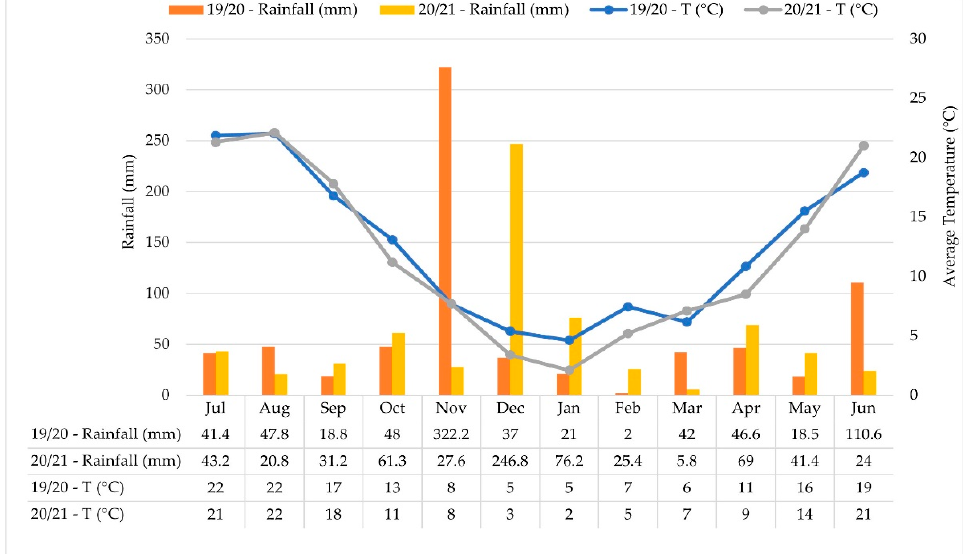
Figure 1. Meteorological data for the cropping seasons 2019/2020 and 2020/2021 derived from Zocca- Monteombraro, Modena, Italy weather station (44°37 ′ 63.23 ″ N, 11°00 ′ 87.52 ″ E, 700 m a.s.l.). Based on USDA soil texture classification, the CA site (exposure N-W) had a silty clay soil, a pH of 7.90 (in water), and 2.39% organic matter content. The PE site (exposure E) had silty claim soil, pH 7.70 (in water), and 3.21% organic matter content. The PR site (exposure S) had silt loam soil, pH 7.90 (in water), and 1.45% organic matter content (Table S1).